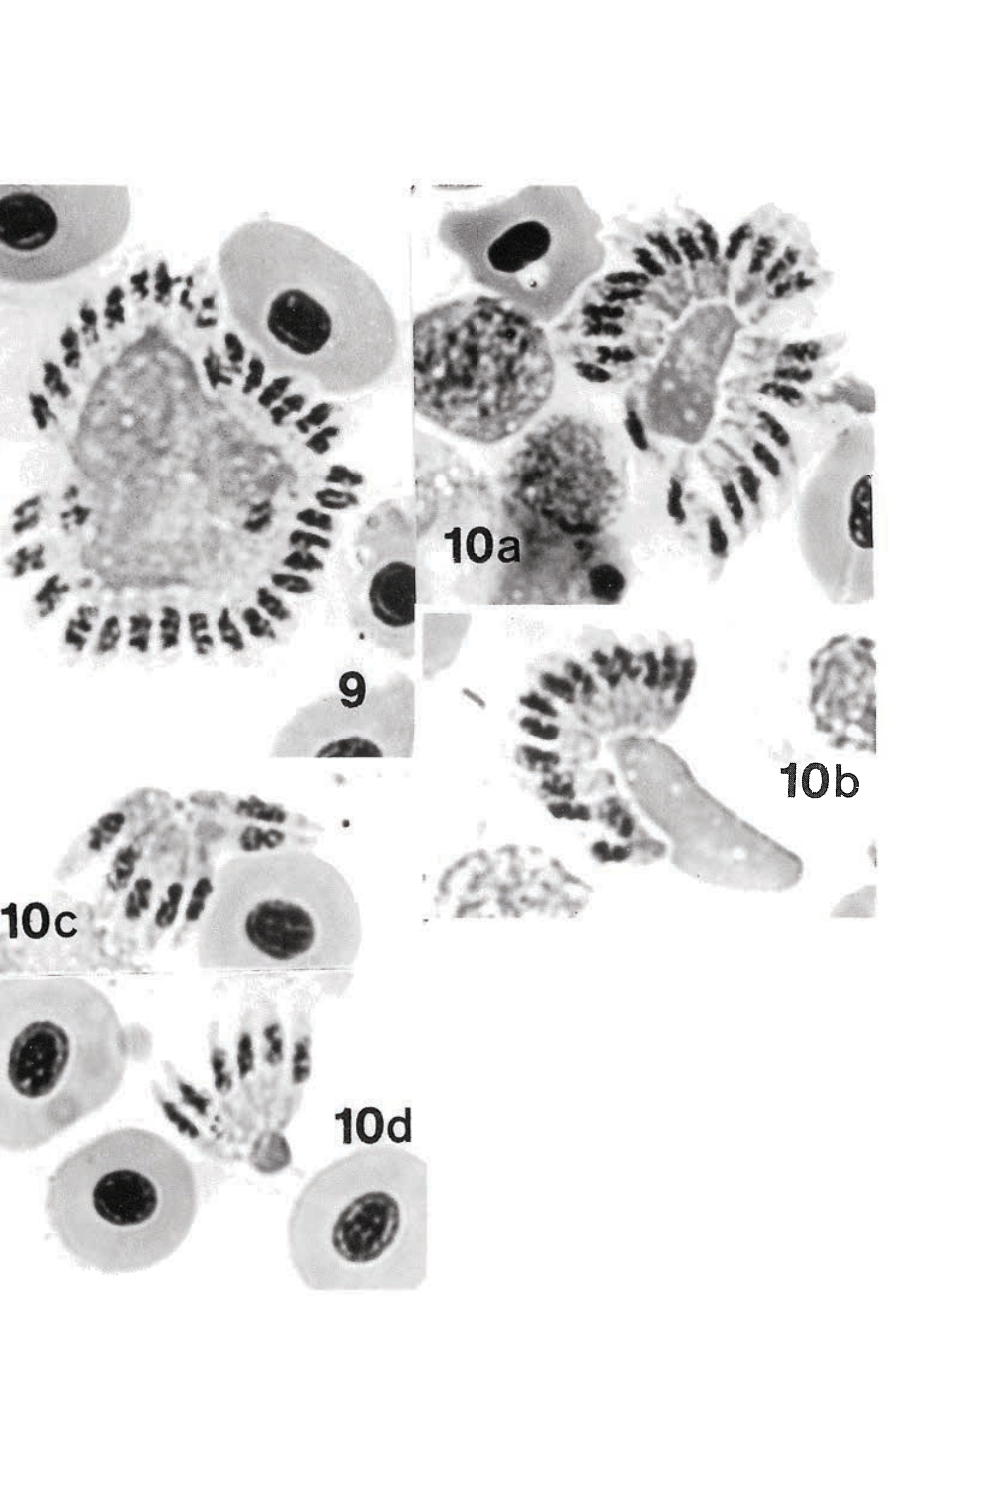
Figs 9-10. Meronts with well-formed merozoites connected with the residual